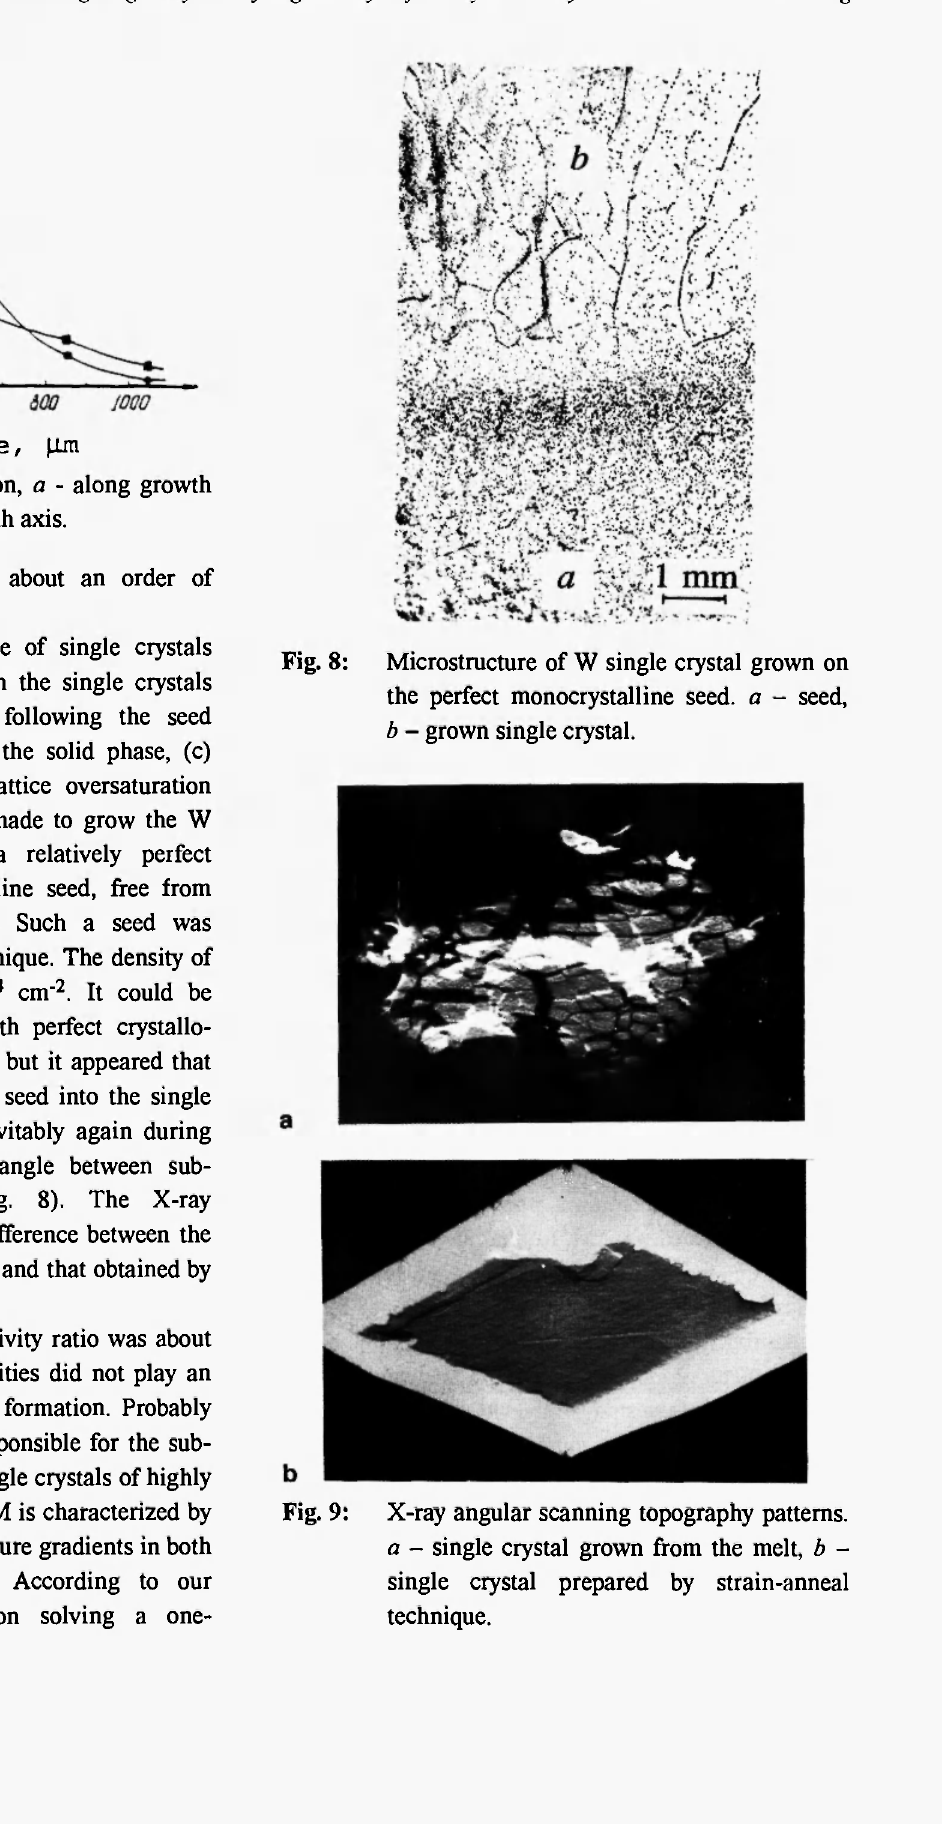
Fig. 7: Subgrain size distribution, a - along growth axis, b - normal to growth axis.